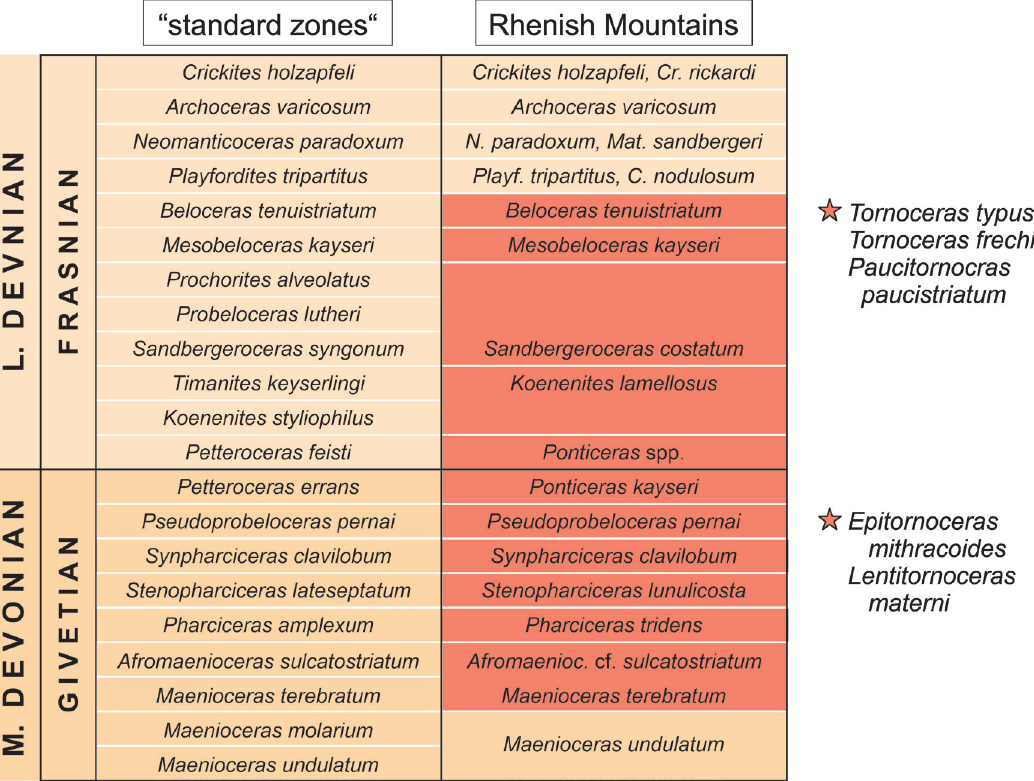
Fig. 2. Givetian and Frasnian ammonoid stratigraphy (after Becker & House 2000), probable extent of the Red Ironstone of Dillenburg and probable position of the ammonoid species described here.